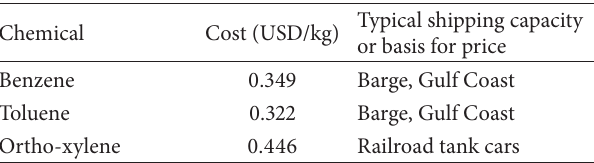
Table 1: Cost of organic compounds (from Turton et al. [18] and Chemical Market